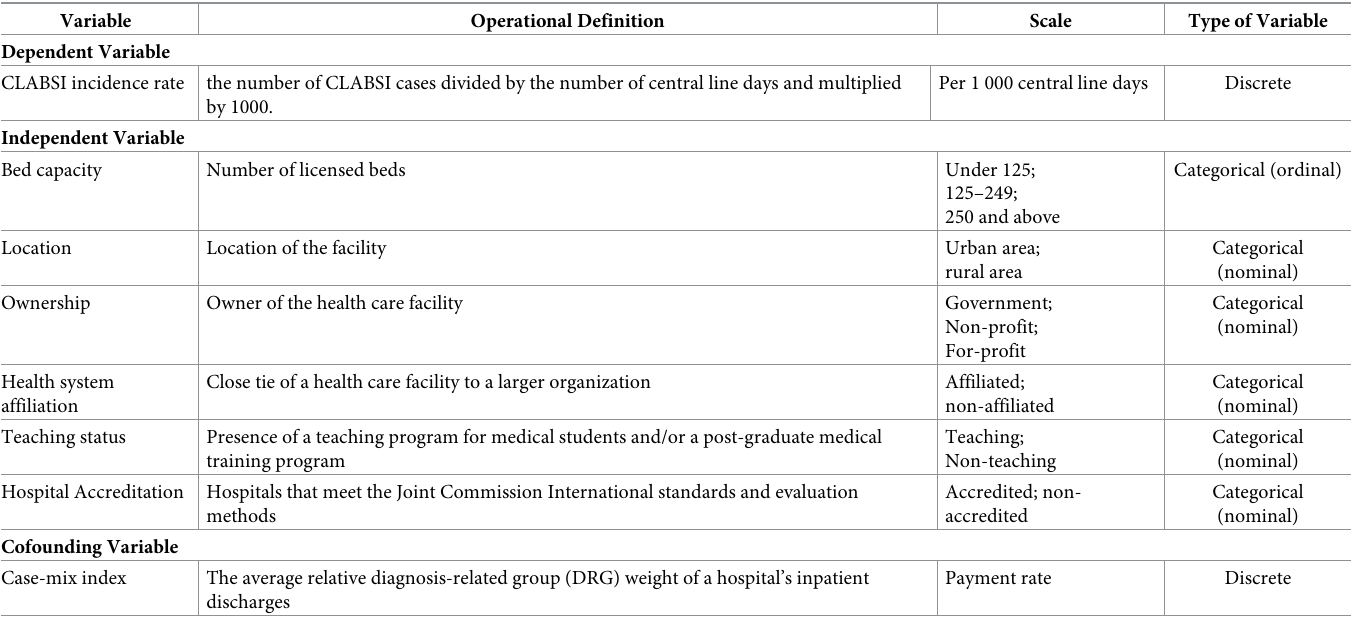
Table 1. Operational definitions of variables in the